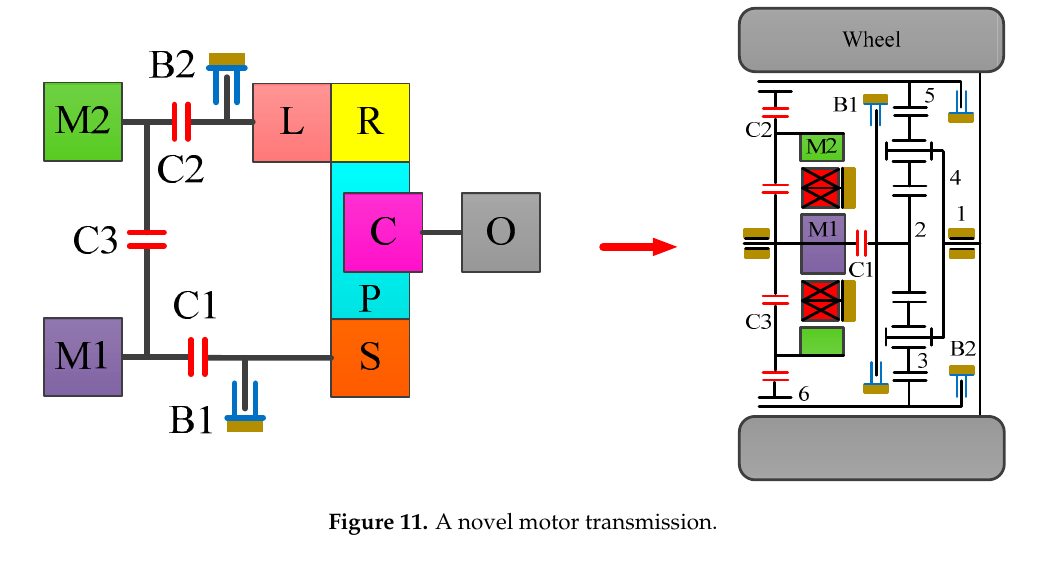
Figure 11. A novel motor transmission.